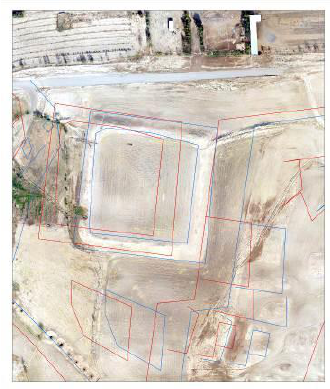
Figure 24 – RPAS orthophoto overlayed by FORMOSAT-2 orthorectified image, transformation parameters (rotation 0,085° and shift (33,310m in X axis and -7,067m in Y axis), FORMOSAT-2 in red and RPAS in